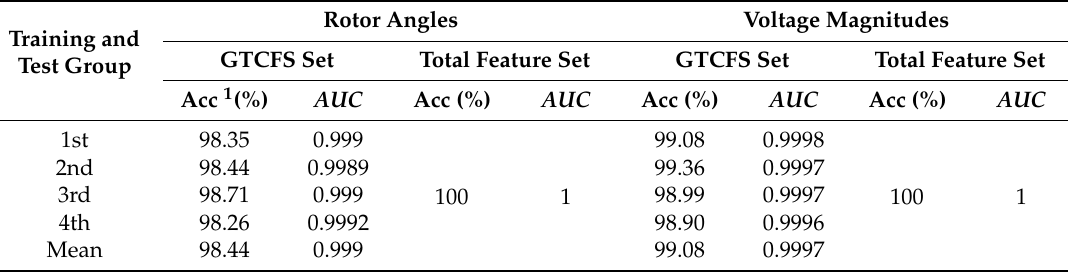
Table 2. Results for the accuracy and area under the ROC curve ( AUC ).